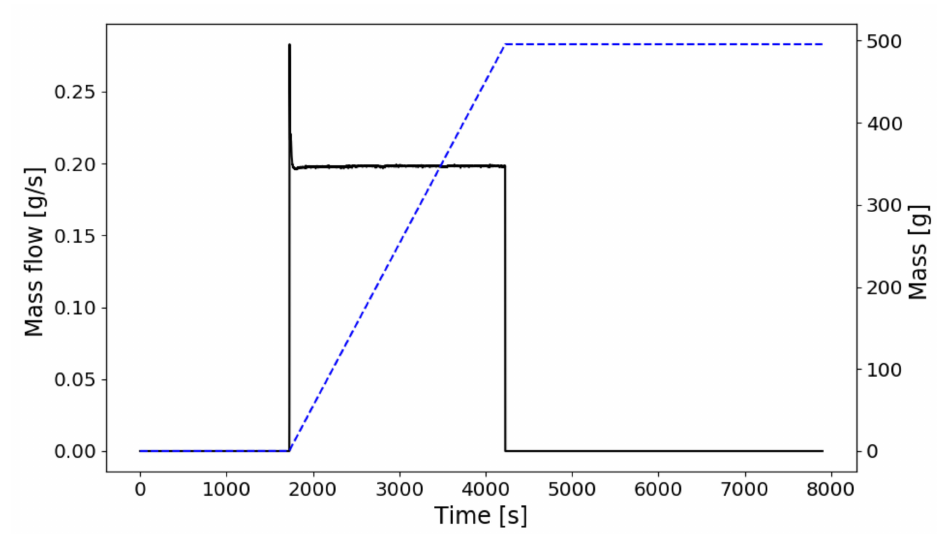
Figure 22. Injection rate and integrated mass of hydrogen during the SSP4 test.